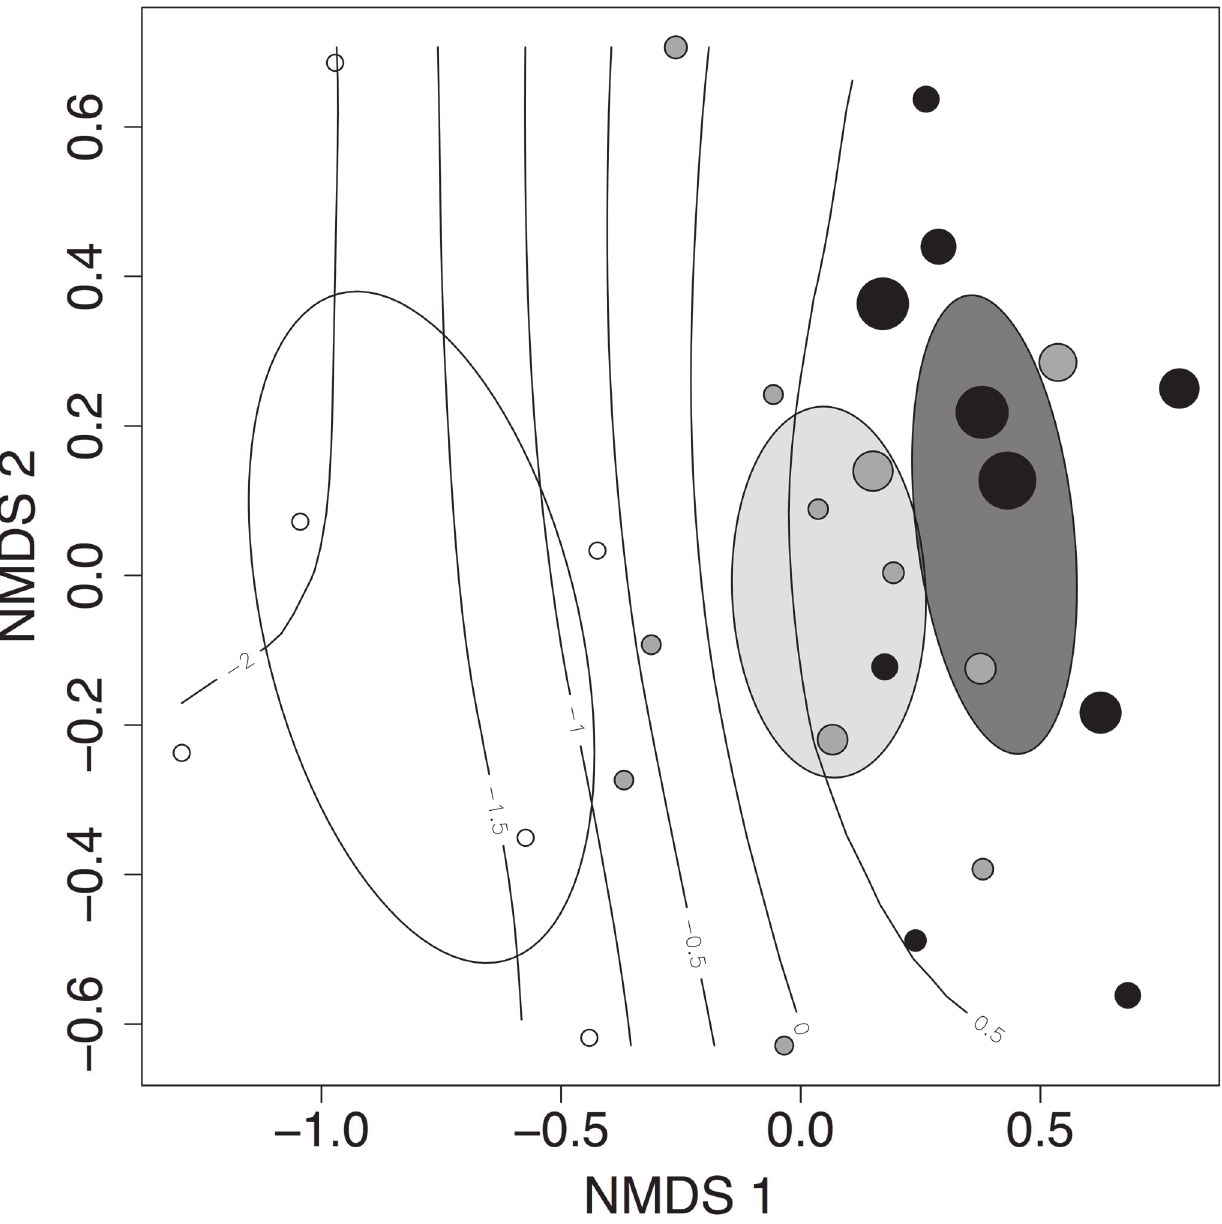
Fig 3. A non-metric multidimensional scaling (NMDS) ordination of the bird assemblages in near pristine forests (black), degraded forests (grey) and open habitats (white). Ellipses are 95% confidence intervals of treatment-level centroids and points are census plots. There was a significant difference between forest bird assemblages and open land assemblages (P = 0.001), but not between near-pristine and degraded forests. The contours indicate the leaf area index and the size of the circle is proportional to the distance to open